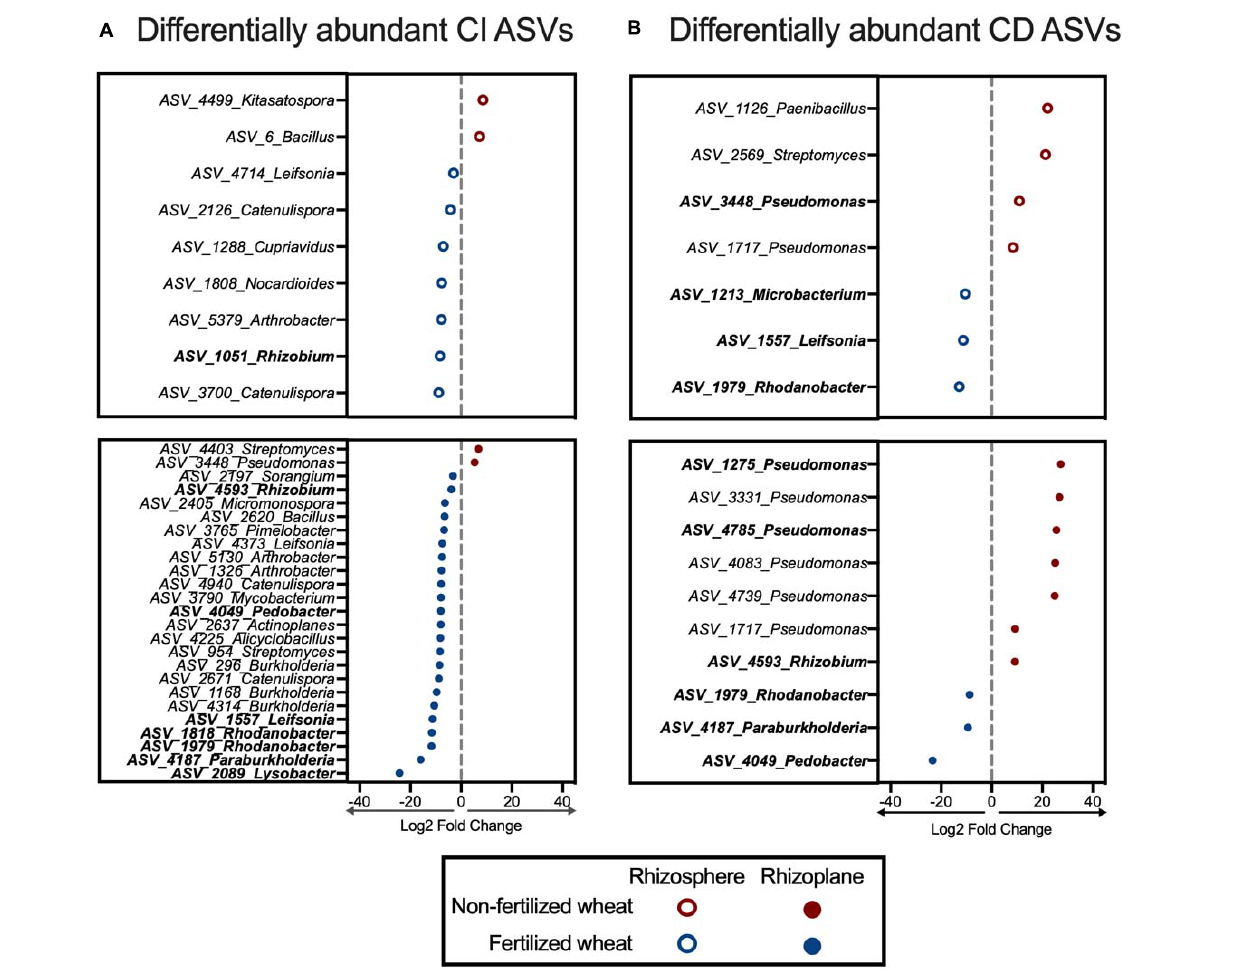
FIGURE 8 | ASVs that significantly differ in abundance in non-fertilized wheat vs. fertilized wheat. Differentially abundant ASVs detected by DESeq2 at a significance level of p − adjusted < 0.05 which were found to be enriched in (A) culture-independent (CI) and (B) culture-dependent (CD) rhizosphere (open circles) and rhizoplane (closed circles) communities in non-fertilized and fertilized wheat. ASVs depicted in bold were also detected in the isolate dataset. Only ASVs classified to genus level are pictured; for full list see Supplementary Material